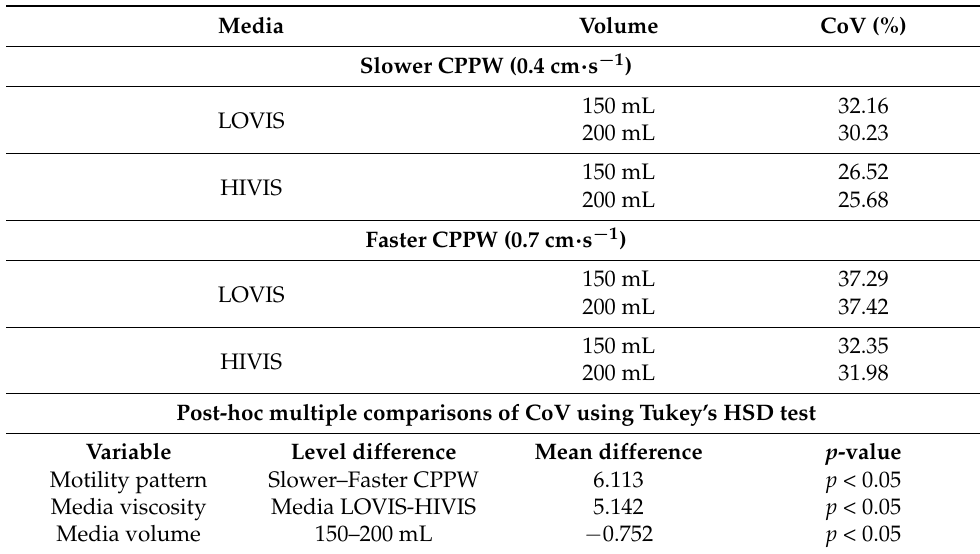
Table 2. Degree of mixing (CoV) scores reported from tagging experiments and Tukey’s post-hoc assessment for significant differences ( n = 4). All interaction effects were deemed insignificant ( p > 0.05) so were not